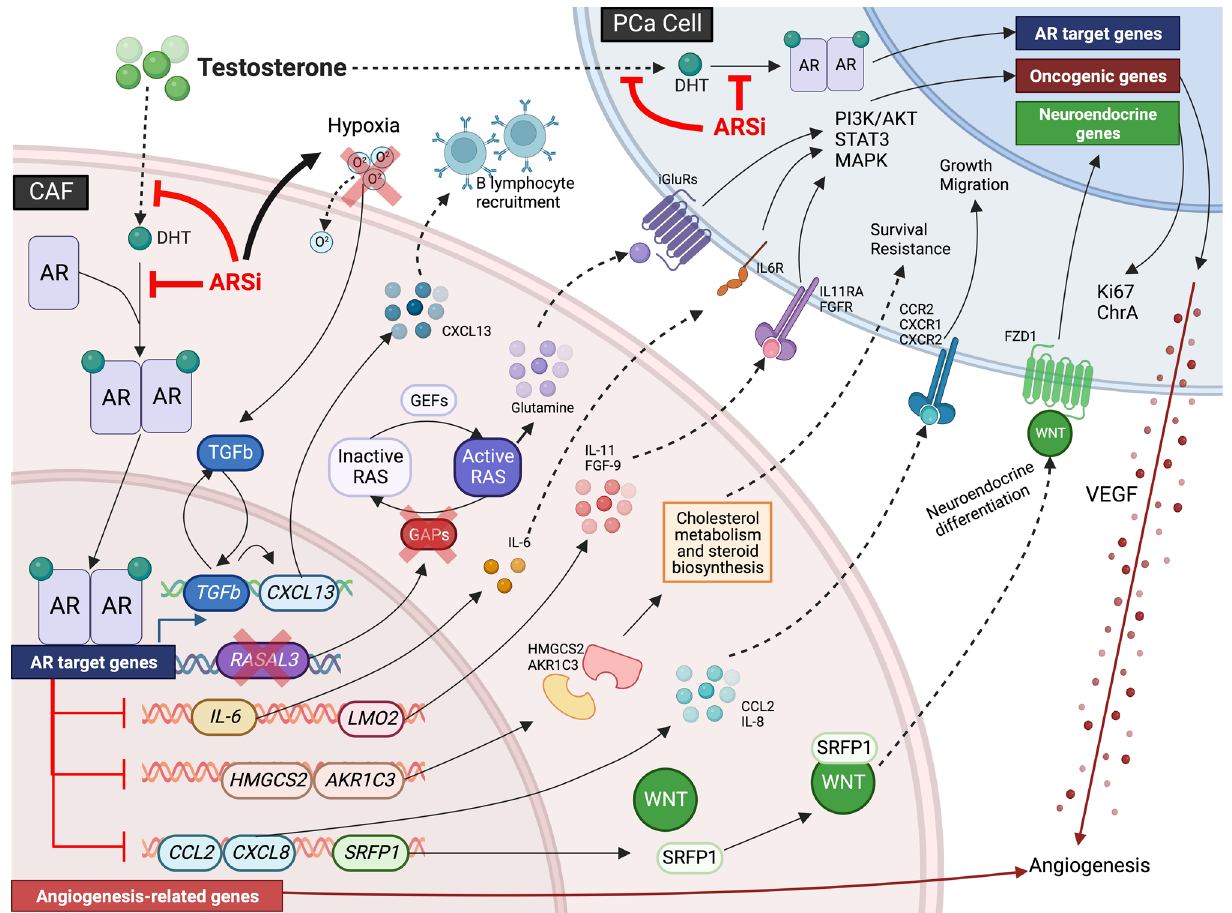
Figure 1. Overview of potential CAF-mediated resistance mechanisms to androgen receptor sig- naling inhibitors (ARSi). To overcome ARSi, (e.g., enzalutamide treatment), CAFs may coordinate a number of processes including; hypoxia-induced TGF β -CXCL13 signaling to increase B-cell re- cruitment, overactivation of RAS resulting in glutamine mediated oncogenic signaling, augmented SRFP1/WNT signaling to increase TNC expression and induce neuroendocrine differentiation, en- hanced cholesterol metabolism and steroid biosynthesis, increased IL-6-mediated angiogenesis and tumor growth, stimulation of CCL2/IL-8 to promote tumor growth and cancer cell migration, and upregulation of IL11/FGF9 to activate STAT3, PI3K/AKT and MAPK signaling. AKR1C3 = aldo-ket reductase family 1 member C3; AKT = protein kinase B; AR = androgen receptor; ARSi = an- drogen receptor signaling inhibition; CCL2 = C_C motif ligand 2; CCR2 = C-C motif chemokine receptor 2; CXCL13 = C-X-C motif ligand 13; CXCR1/2 = C-X-C motif chemokine receptor 1/2; FGF-9 = fibroblast growth factor 9; DHT = dihydrotestosterone; FGFR = fibroblast growth factor receptor; FZD1 = Frizzled receptor 1; GAPs = GTPase activating proteins; GEFs = guanine nucleotide exchange factors; HMGCS2 = 3-hydroxy-3-methylglutaryl coenzyme A synthase 2; iGluR = inotropic glutamate receptor; IL-6 = interleukin 6; IL-8 = interleukin 8; IL-11 = interleukin 11; IL11RA = in- terleukin 11 receptor A; LMO2 = LIM domain only 2; MAPK = mitogen-activated protein kinase; PCa = prostate cancer; PI3K = phosphatidylinositol 3 kinase; RASAL3 = RAS protein activator like 3; SRFP1 = secreted frizzled-related protein 1; STAT3 = signal transducer and activator of transcription 3; TGF β = transforming growth factor β ; TNC = tenascin C; VEGF = vascular endothelial growth factor; WNT = wingless-related integration site. Created with Biorender.com (accessed on 1 December 2022) and data sourced from